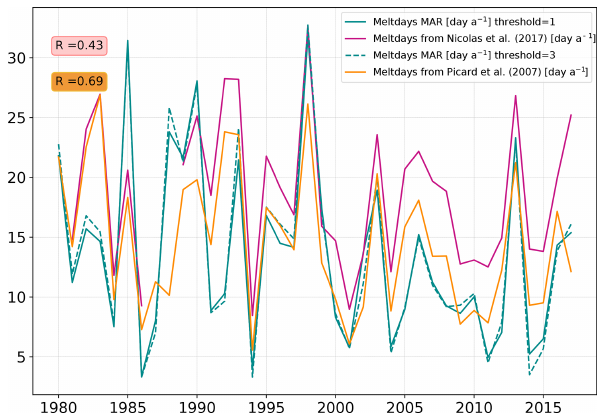
Figure 7. Time series of the number of melt days per summer (DJF) averaged over the part of the domain with more than 3 melt days per year on average (which approximately corresponds to the ice shelf zone), derived from two satellite products and simulated by MAR (defined using a melt rate threshold of either 1 or 3mmw.e.d − 1 )